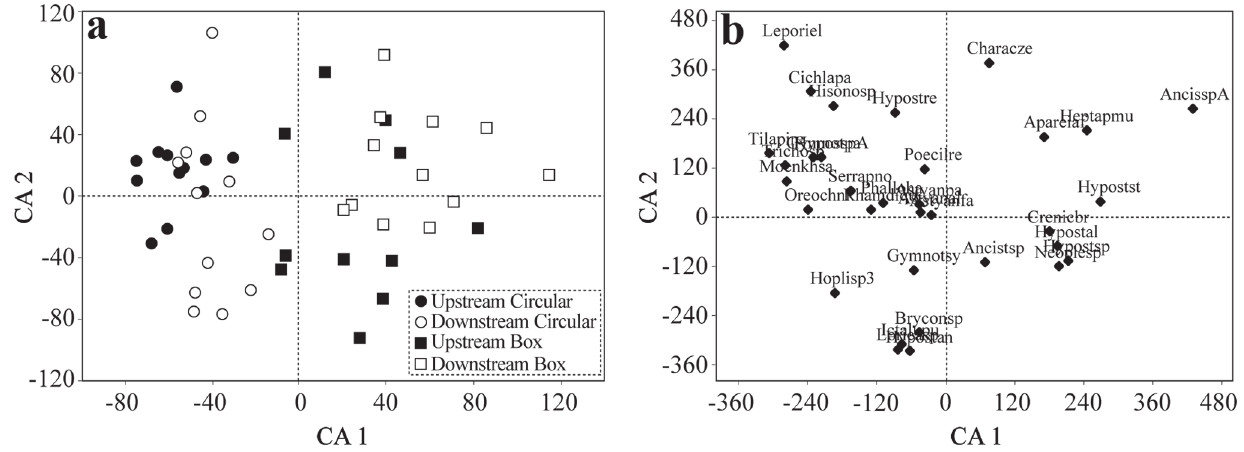
Fig. 9. Results of Correspondence Analysis (CA) between the sampled stretches of the Lopeí stream - circular culvert and Pindorama stream - box culvert ( a ), and species distribution scores ( b